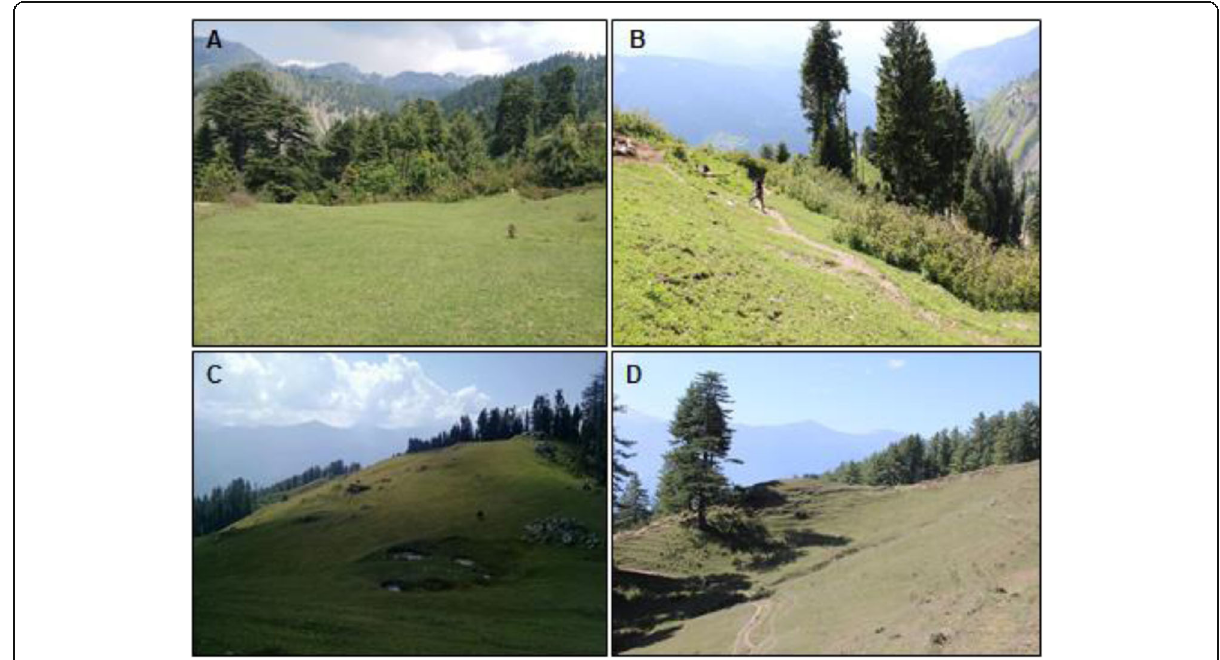
Fig. 2 Sampling sites location. a Khanitop. b Below Padhri. c Guldanada. d Budh Ro